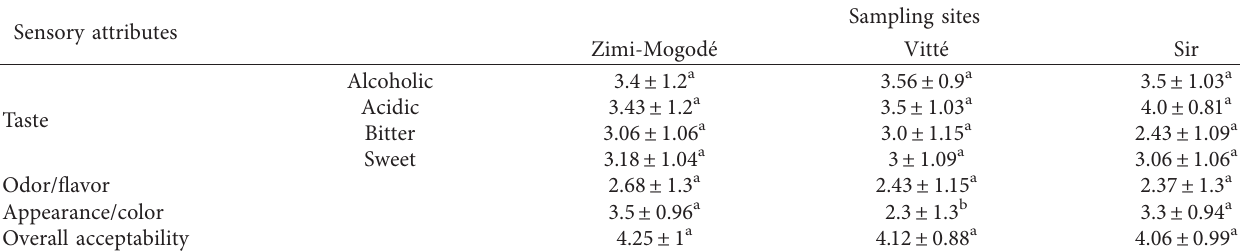
Table 6: Sensory quality of the “T´ea L´emi” wine from northern Cameroon.